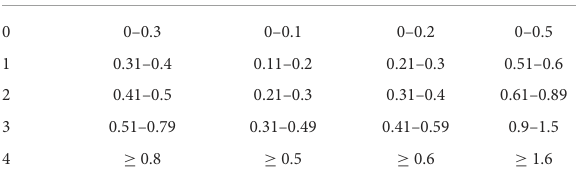
IMT ranges (in millimeters) and their corresponding scores are outlined. Values for axillary arteries are multiplied by three to account for it having fewer branches. The scores are added to give a Total Halo Score, with a maximum value of 48. Halo scores are evaluated on serial scans to assess for wall-thickness regression. STA, Superficial